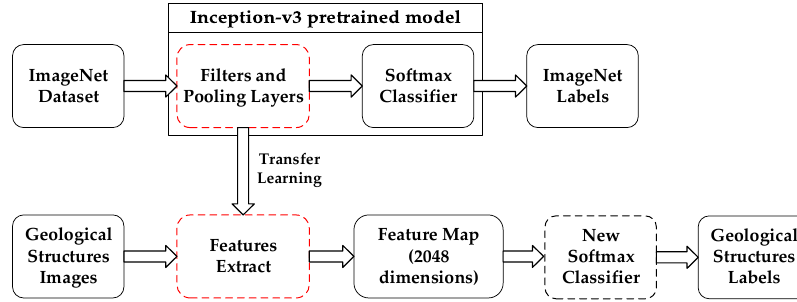
Figure 5. The process of retraining Inception-v3.